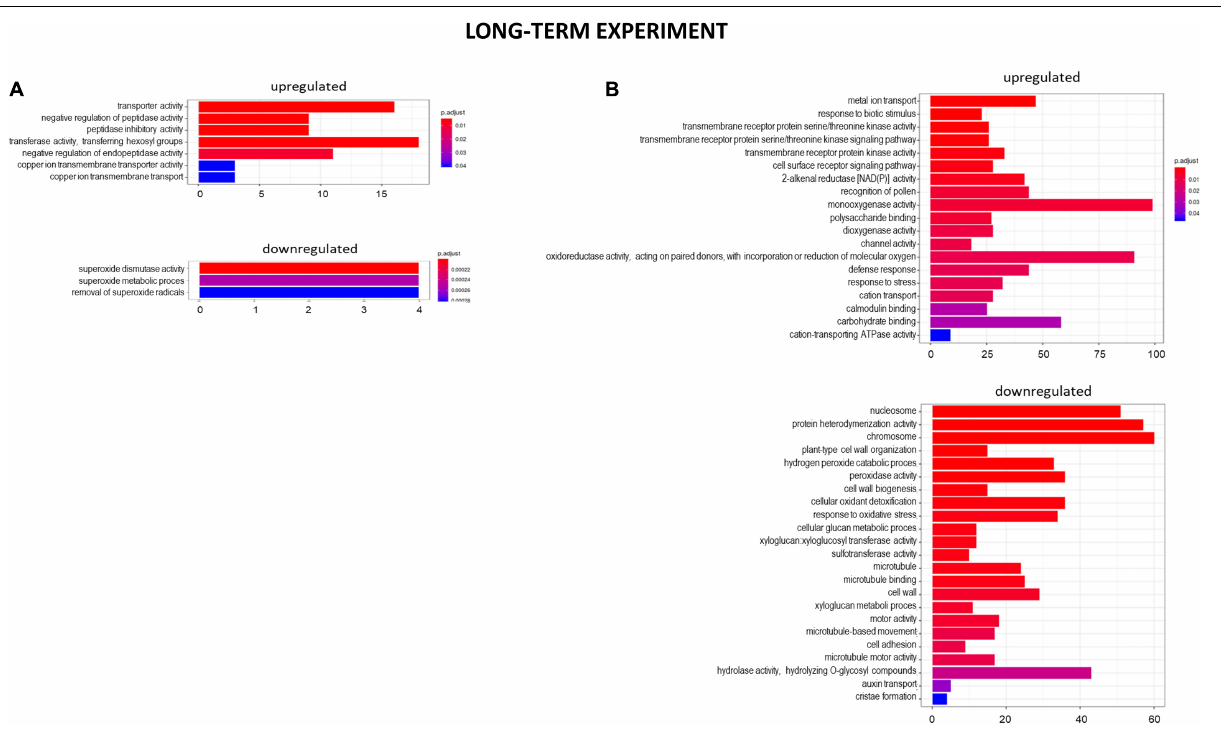
FIGURE 10 | GO term enrichment of genes upregulated and downregulated in the long-term experiment by low pH (A) and Al (B) . The numbers on the X axis indicates the number of genes; p.adjust means FDR adjusted p